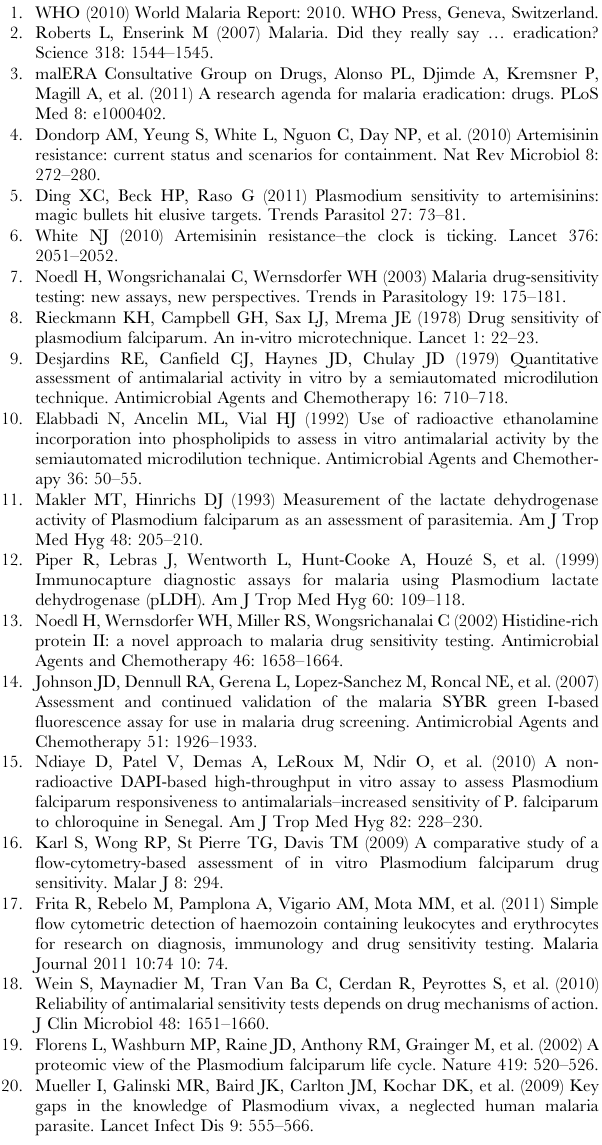
Table S2 In vitro parasite reduction ratio and clearance time in response to various concentrations of chloro- quine and lumefantrine. (DOC) Table S3 In vitro parasite reduction ratio and clearance time in response to atovaquone, GW648495X, GW844520X. Table S4 Provider and reference number of the com- pounds used in this study.